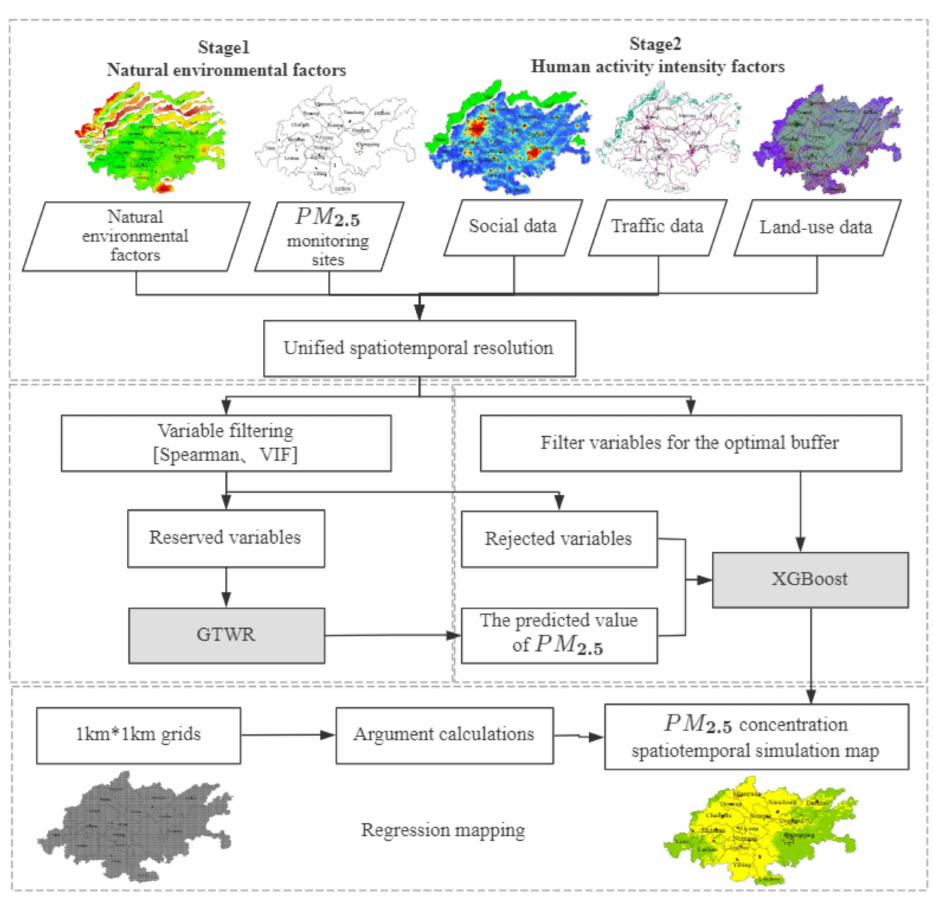
Figure 2. GTWR-XGBoost technology